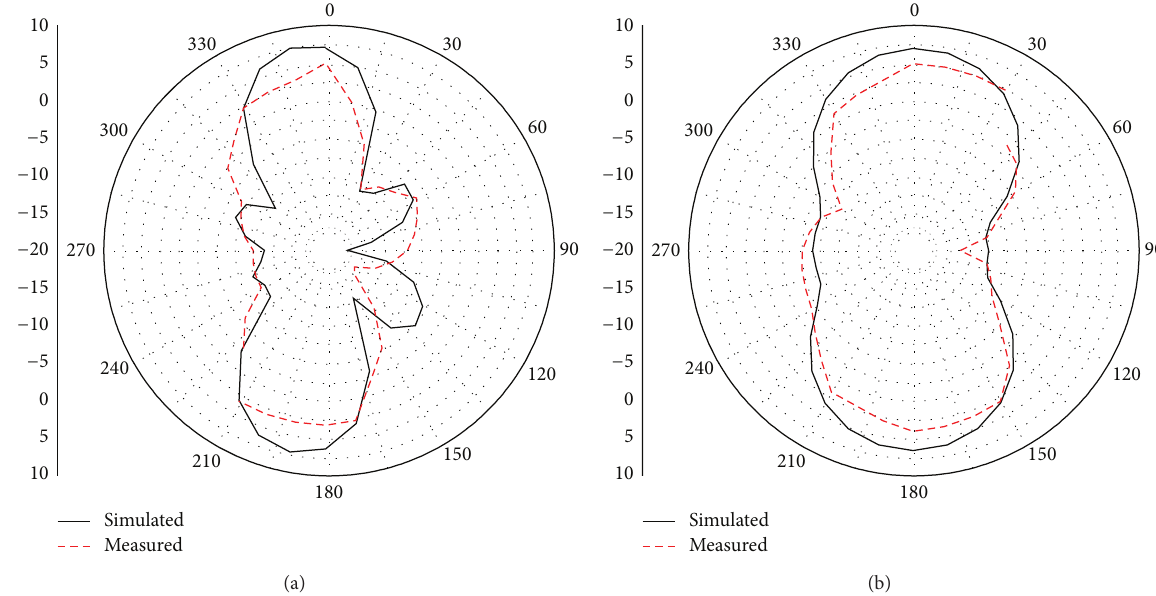
Figure 9: Simulated and measured radiation pattern. (a) E-plane and (b) H-plane.